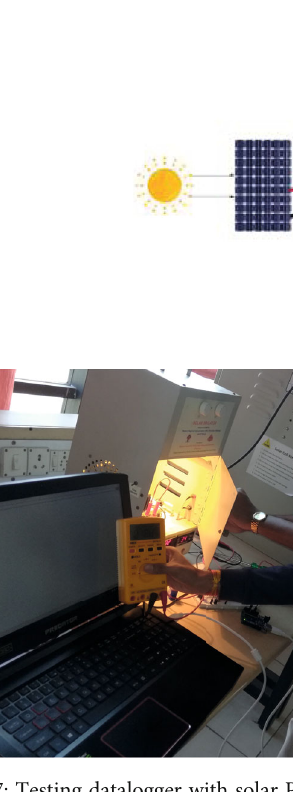
Figure 7: Testing datalogger with solar PV emulator.